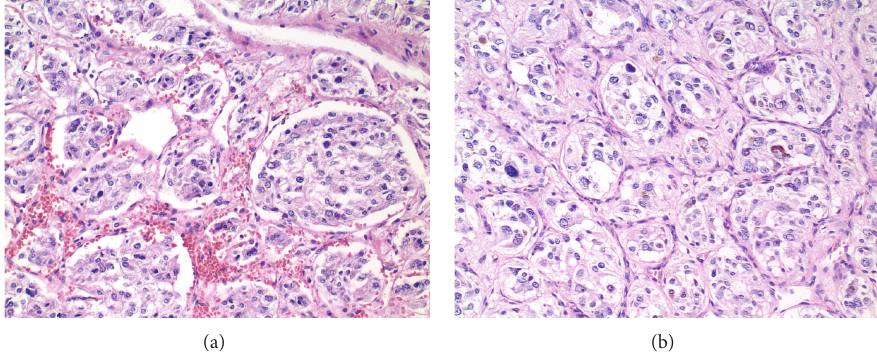
F 2: Histologic sections from theright (a) andle (b) showan alveolar (zellballen) architecture with tumorcells surrounded bya delicate �brous framework. e tumor cells show variable nuclear pleomorphism and contain granular and basophilic to amphophilic cytoplasm. Hemorrhage (a) and hemosiderin (b) are common in these tumors. Both images are at 200x magni�cation and are stained with hematoxylin and